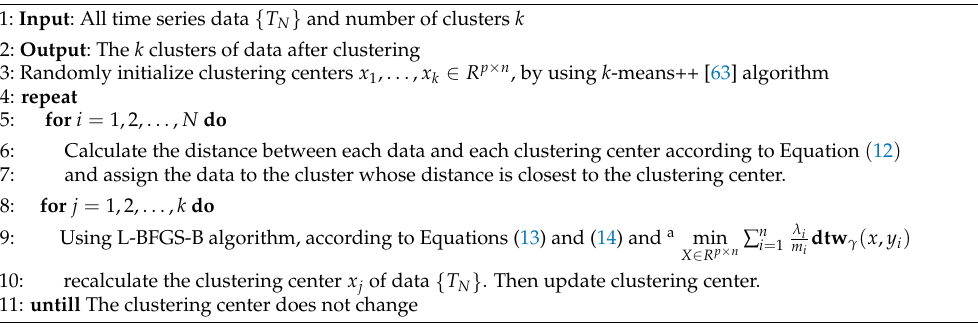
Algorithm 3 Based on K-Means time series clustering ( a λ i is the weight of each datum within the same